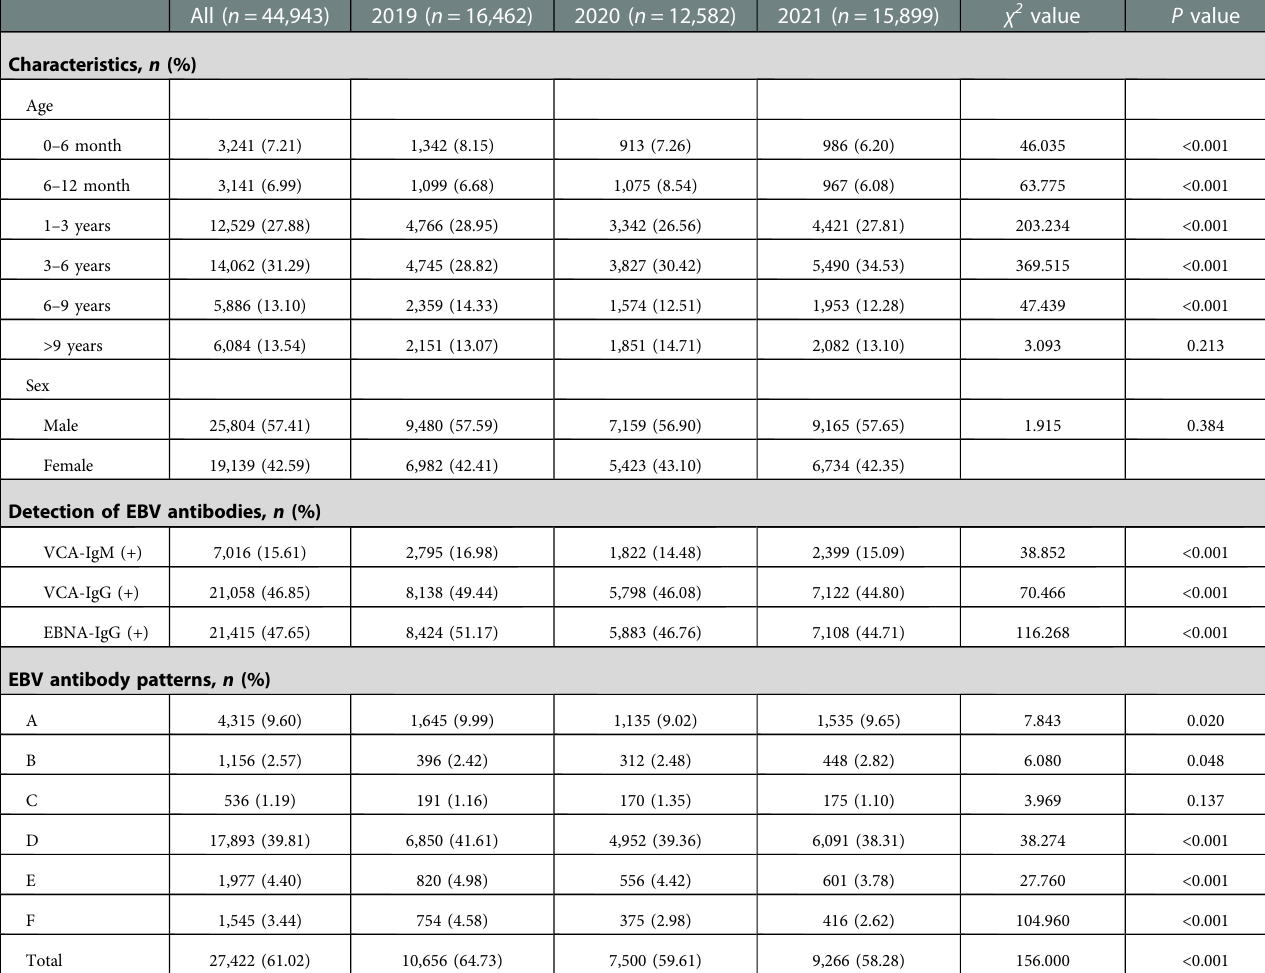
TABLE 2 Patient characteristics and detection of EBV antibodies between January 2019 and December 2021. All ( n =